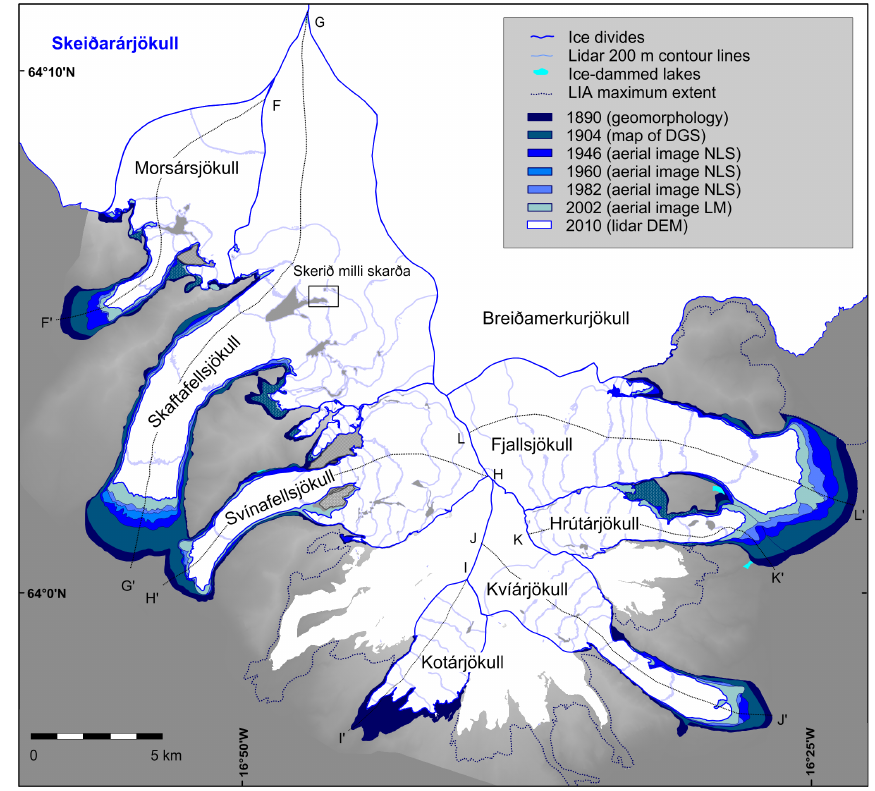
Figure 5. The extent of Öræfajökull’s outlet glaciers and Morsárjökull at different times. The surface map is derived from the lidar DEM, showing 200m contour lines. The locations of longitudinal profiles shown in Fig. 8 are indicated with capital letters F-F’, G-G’, etc. The area covering the nunataks east of “Skerið milli skarða”, shown in Fig. 3 is outlined. The ice extent in 1904 is uncertain in the mountains surrounding Morsárjökull and Skaftafellsjökull, due to distorted topography on the old map. DGS: Danish General Staff, NLS = National Land Survey of Iceland, LM: Loftmyndir ehf. The ∼ 1890 glacier extent is from Hannesdóttir et al.